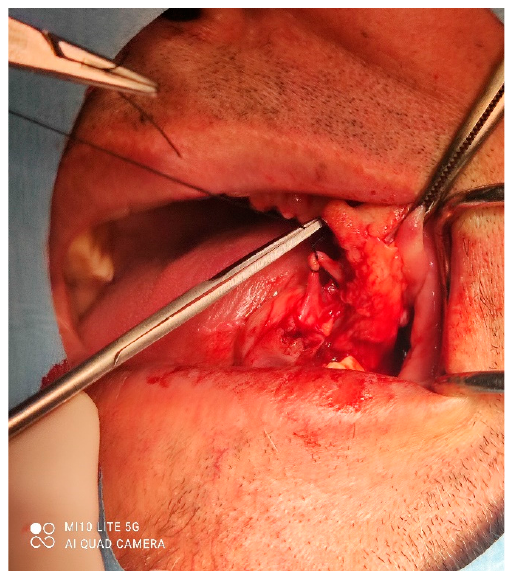
Figure 3. Removal of the mass.